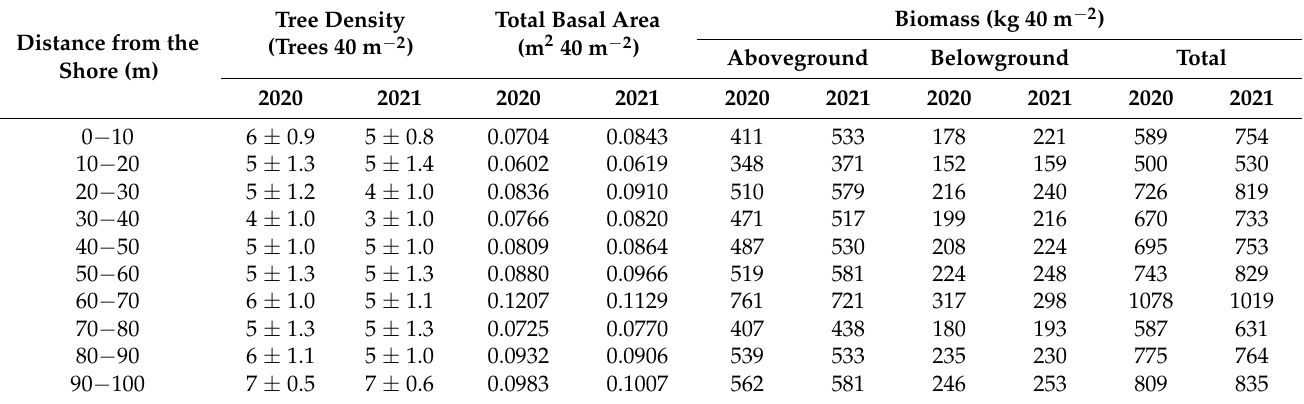
Table 1. Quantitative characteristics of vegetation structure (mean ± SE) across the belt transects in